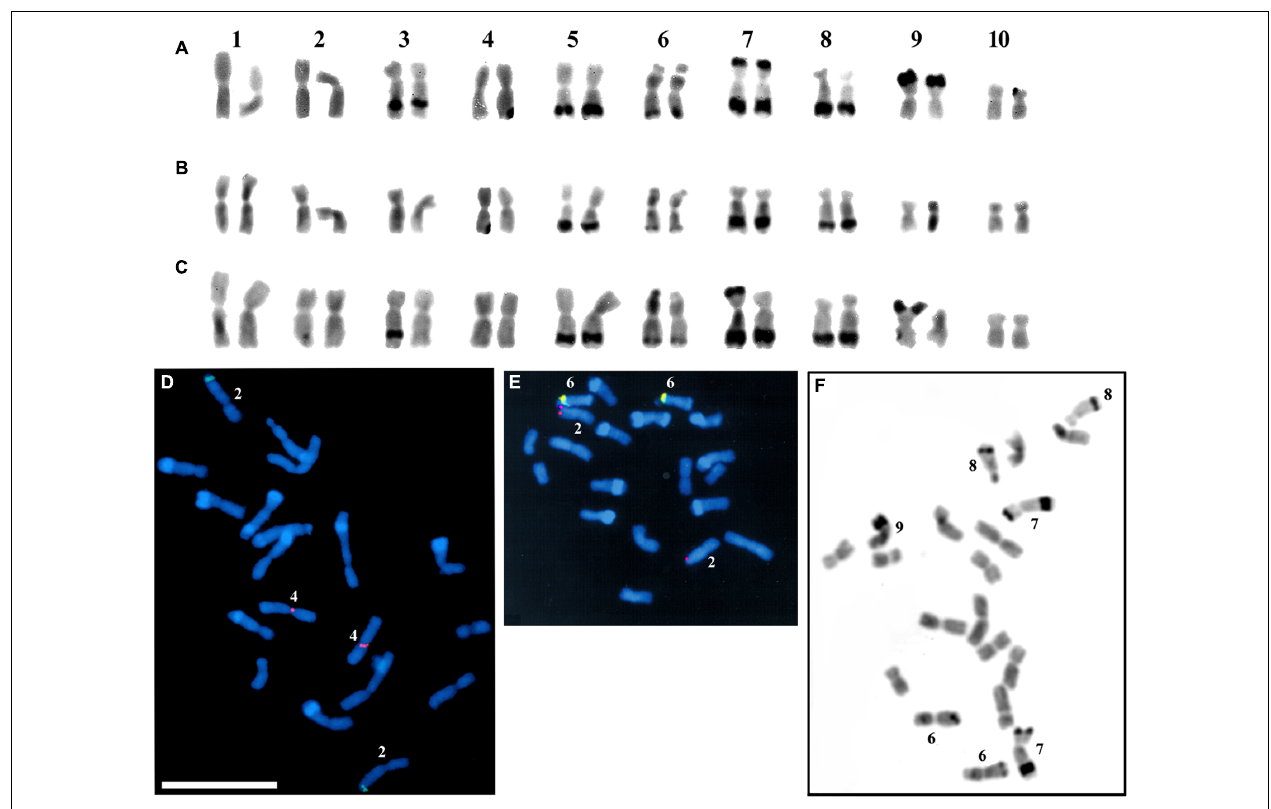
FIGURE 1 | Somatic chromosomes of JD lines and hybrids. C-banded karyograms from lines 441123 (A) , 444331 (B), and the 441123 × 444331 hybrid (C) ; metaphase of the 441123 × 442612 hybrid showing 5S rDNA (green) and Cent4 (red) FISH signals (D) ;